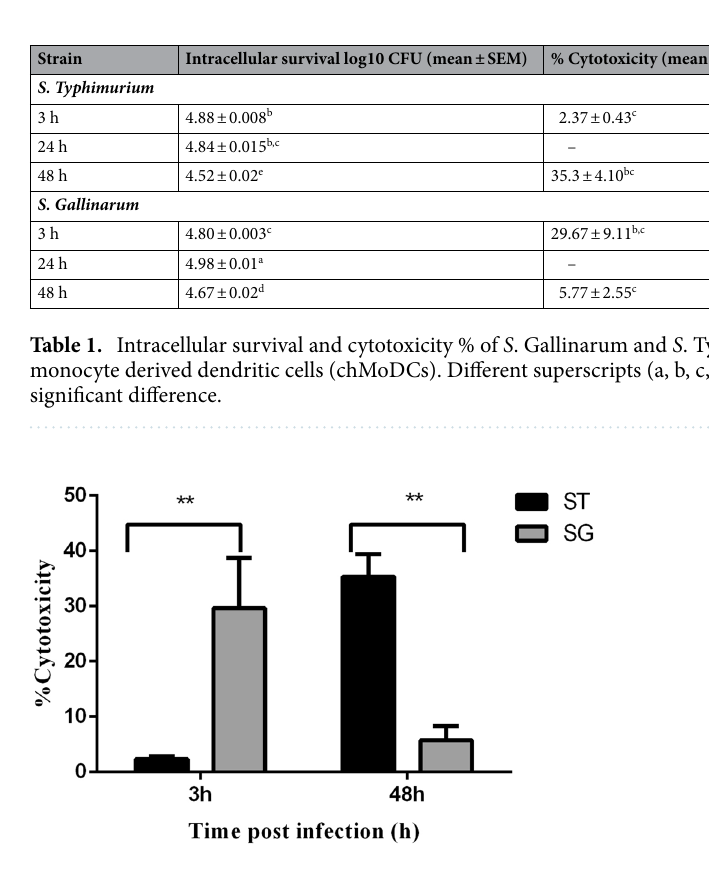
Figure 4. Measurement of cytotoxicity in chMoDCs induced by S . Gallinarum (SG) and S . Typhimurium (ST) with a multiplicity of infection of 10. The cytotoxicity level was determined by measuring lactate dehydrogenase (LDH) released to the cell culture supernatant at 3 and 48 h post-infection. Data were analysed by two-way repeat measures ANOVA for S. Typhimurium and S. Gallinarum at 3 and 48 h post-infection. Values shown are mean ± SEM of triplicates from three independent experiments and expressed as percentage relative to lysis buffer treated cells (mean) ( **p <